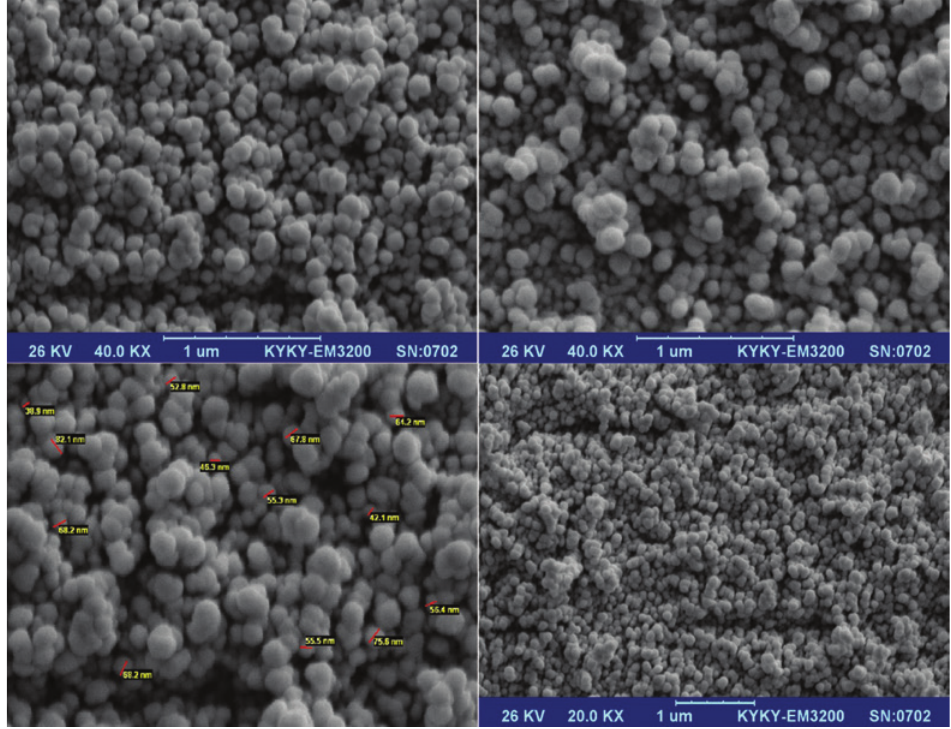
O nanoparticles synthesized in the presence of 12 19